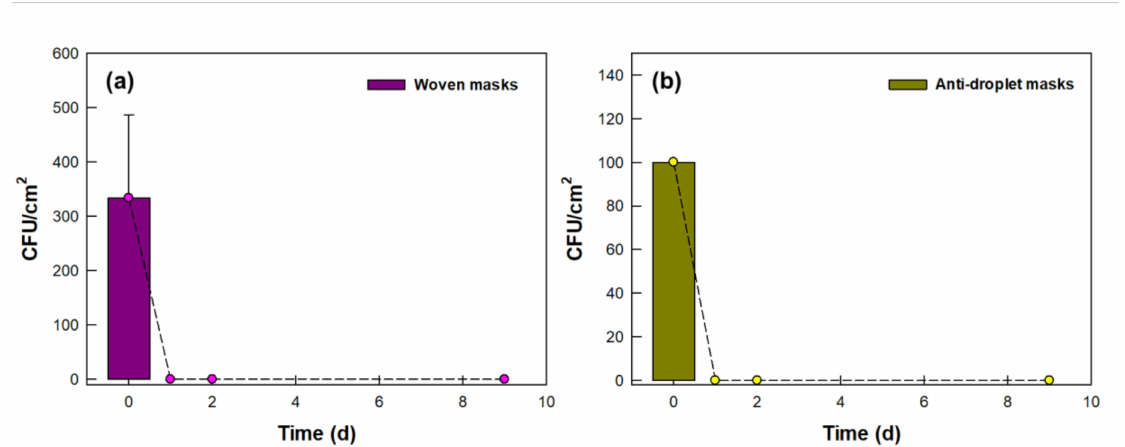
Figure 5. Colony forming unit (CFU)/cm 2 values of airborne B. subtilis from bioaerosols on ( a ) woven and ( b ) anti-droplet face masks after these masks were used to filter particulate matters (PMs) and airborne droplets containing bacteria. Error bars represent standard deviation of the data ( n = 9). The dashed line shows a trend of each result.